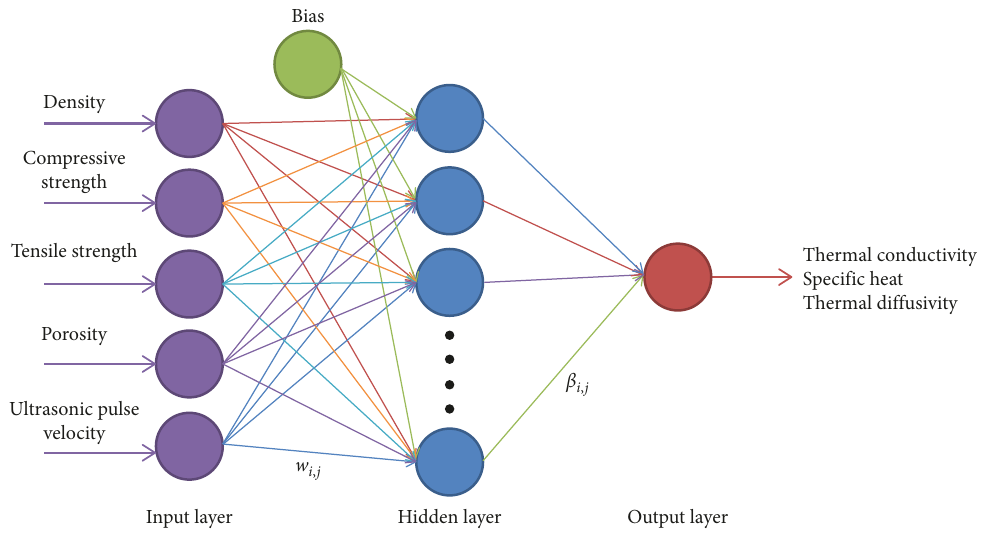
Figure 3: Construction of the ANN